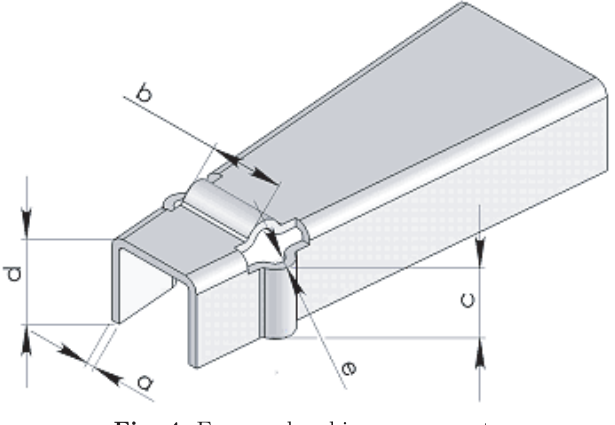
Fig. 4. Energy absorbing